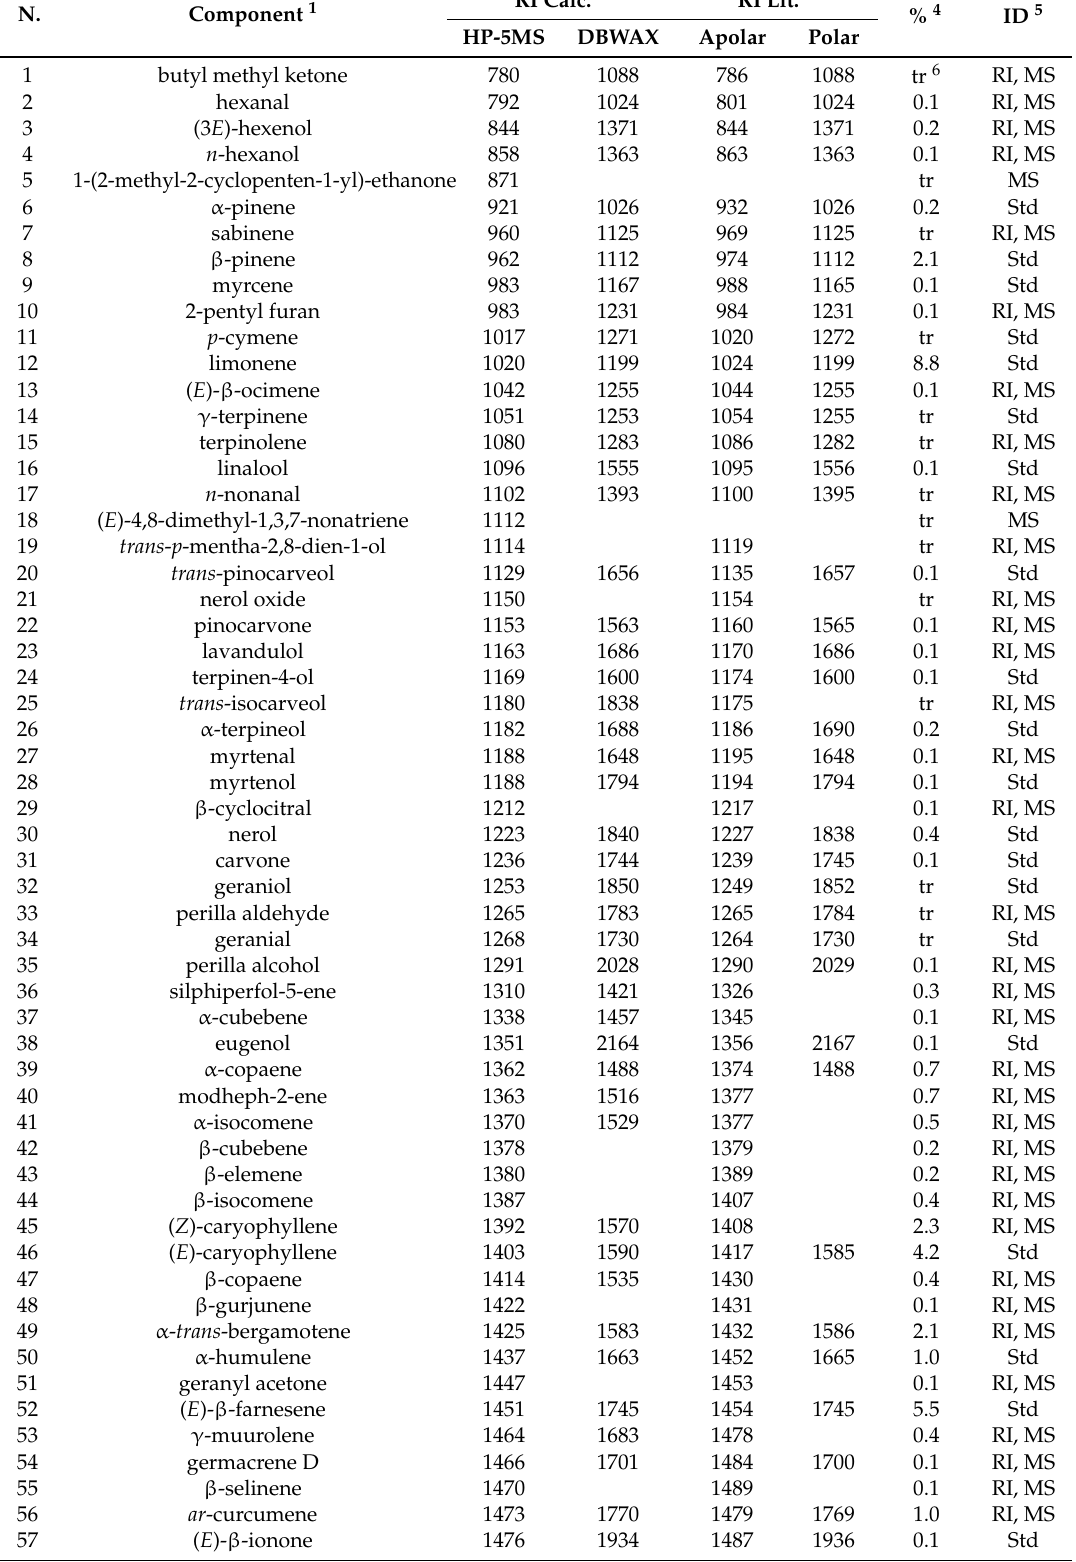
Table 1. Composition of the essential oil hydrodistilled from the aerial parts of Erigeron floribundus .